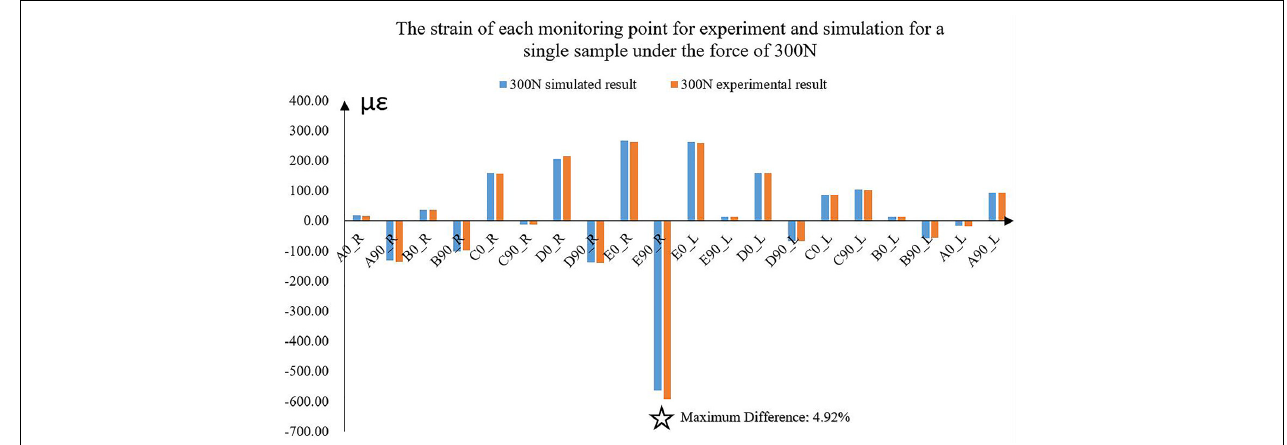
FIGURE 4 | The experimental and simulated strains of the 10 monitoring points for a sample under the force of 300 N. (cid:73) represented the maximum difference between experimental and simulated strains. A located at the bilateral mandibular condyle necks, B located at the bilateral mandibular angles, and C, D, and E located at the bilateral mandibular bodies. 0 and 90 represented the horizontal and vertical directions, respectively. R and L represented the right and left sides,